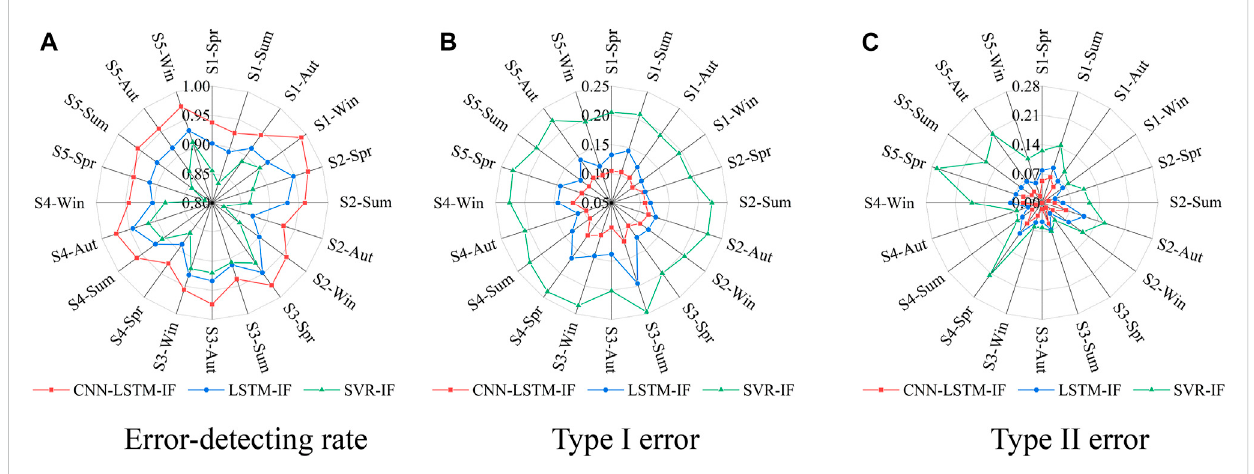
FIGURE 5 Comparison of the error-detecting capability of the three algorithms: (A) Error-detecting rate, (B) Type I error, (C) Type II error [S1-5 is short for section